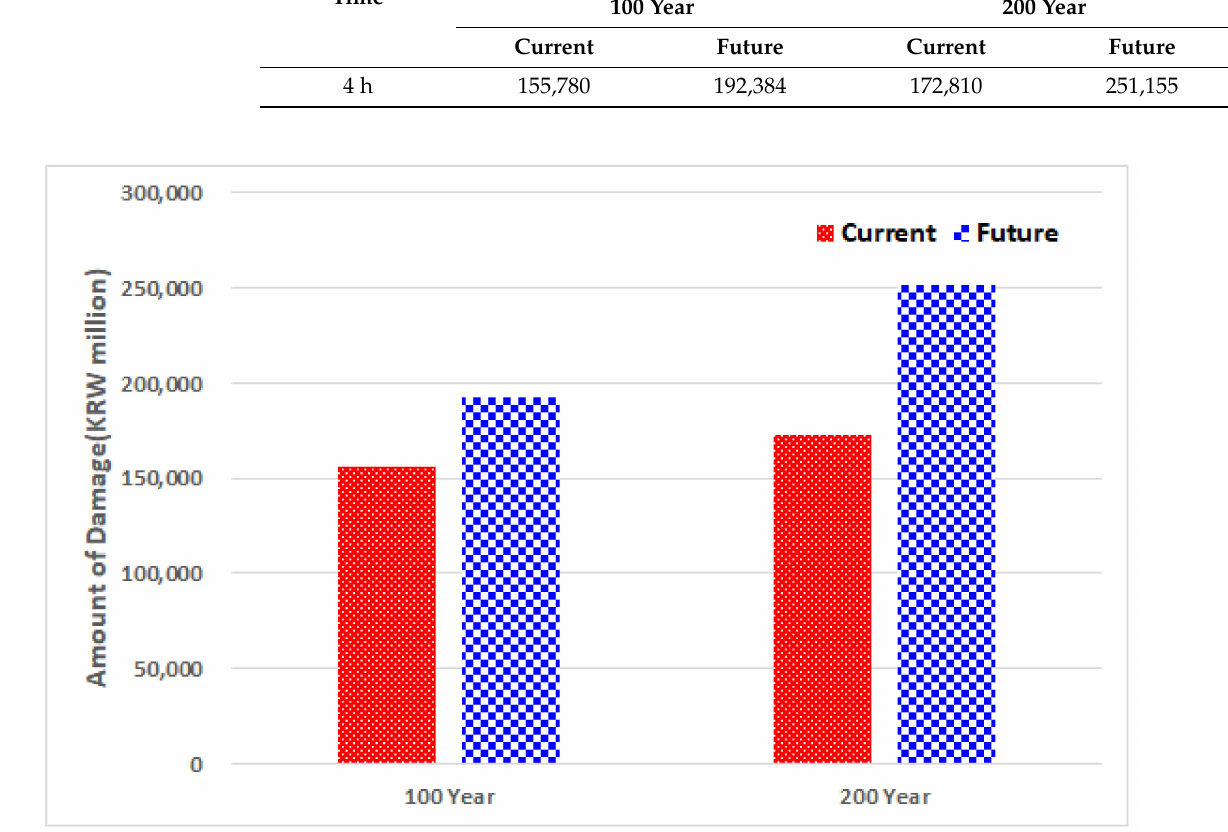
Figure 16. Result Flood